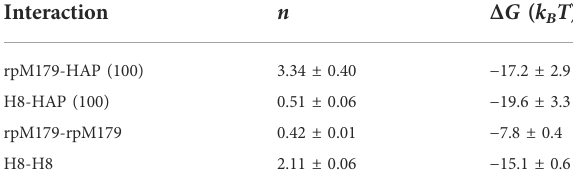
Supplementary Figure S5B for an analysis of the second layer adsorption to obtain oligomer-oligomer binding energies. Table 1 shows the resulting Hill coef fi cients, n , oligomer-HAP, and oligomer-oligomer binding energies. The data show that the oligomer-HAP binding energy and oligomer-oligomer binding energy were higher for H8 compared to rpM179.